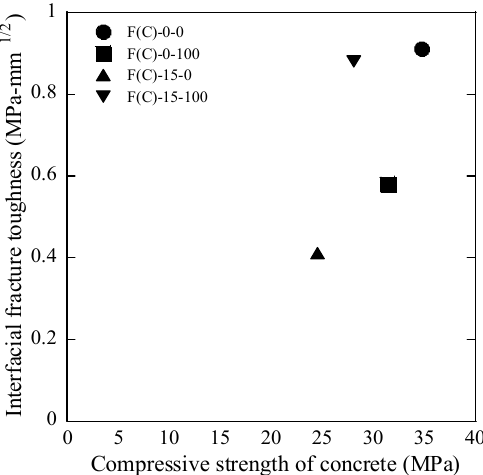
Figure 10. Correlation between the compressive strength and the